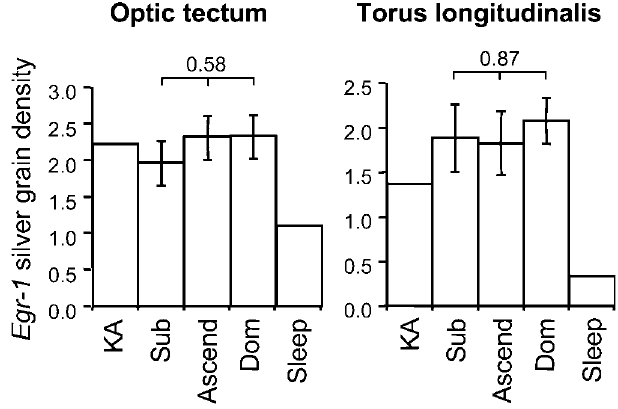
Figure 4. egr-1 Induction in the OT and TL Mean 6 SE silver grain density in the OT or the TL did not vary among subordinate (Sub), ascending (Ascend), and dominant (Dom) males. The p -values for the effect of social opportunity are shown above bars. Shown for comparison is a male injected with kainic acid (KA) and a male sacrificed just before onset of lights (Sleep). DOI: 10.1371/journal.pbio.0030363.g004